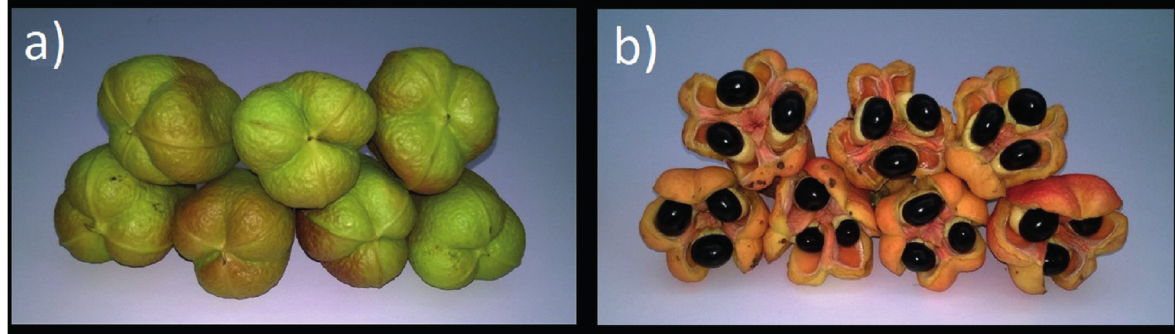
Figure 1 - Ackee fruit at different ripening stages. a ) Maturation Stage 1 closed fruit, green pod, and green seed and b ) Maturation Stage 5, ripe fruit with exposed arilli, open pods, orange-red, and black